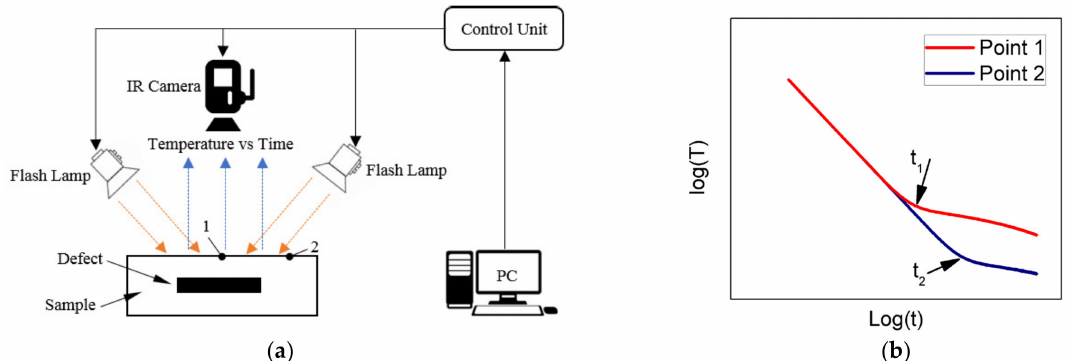
Figure 4. ( a ) Experimental configuration of the pulsed thermographic inspection under the reflection mode, where Point 1 denotes a surface location with a defect underneath and Point 2 denotes a location on the sample surface with no defect underneath. ( b ) Typical observed time–temperature decay curves in the logarithmic domain for Points 1 and 2, respectively, where the times of t1 and t2 are the key for measuring the thickness of the local materials.